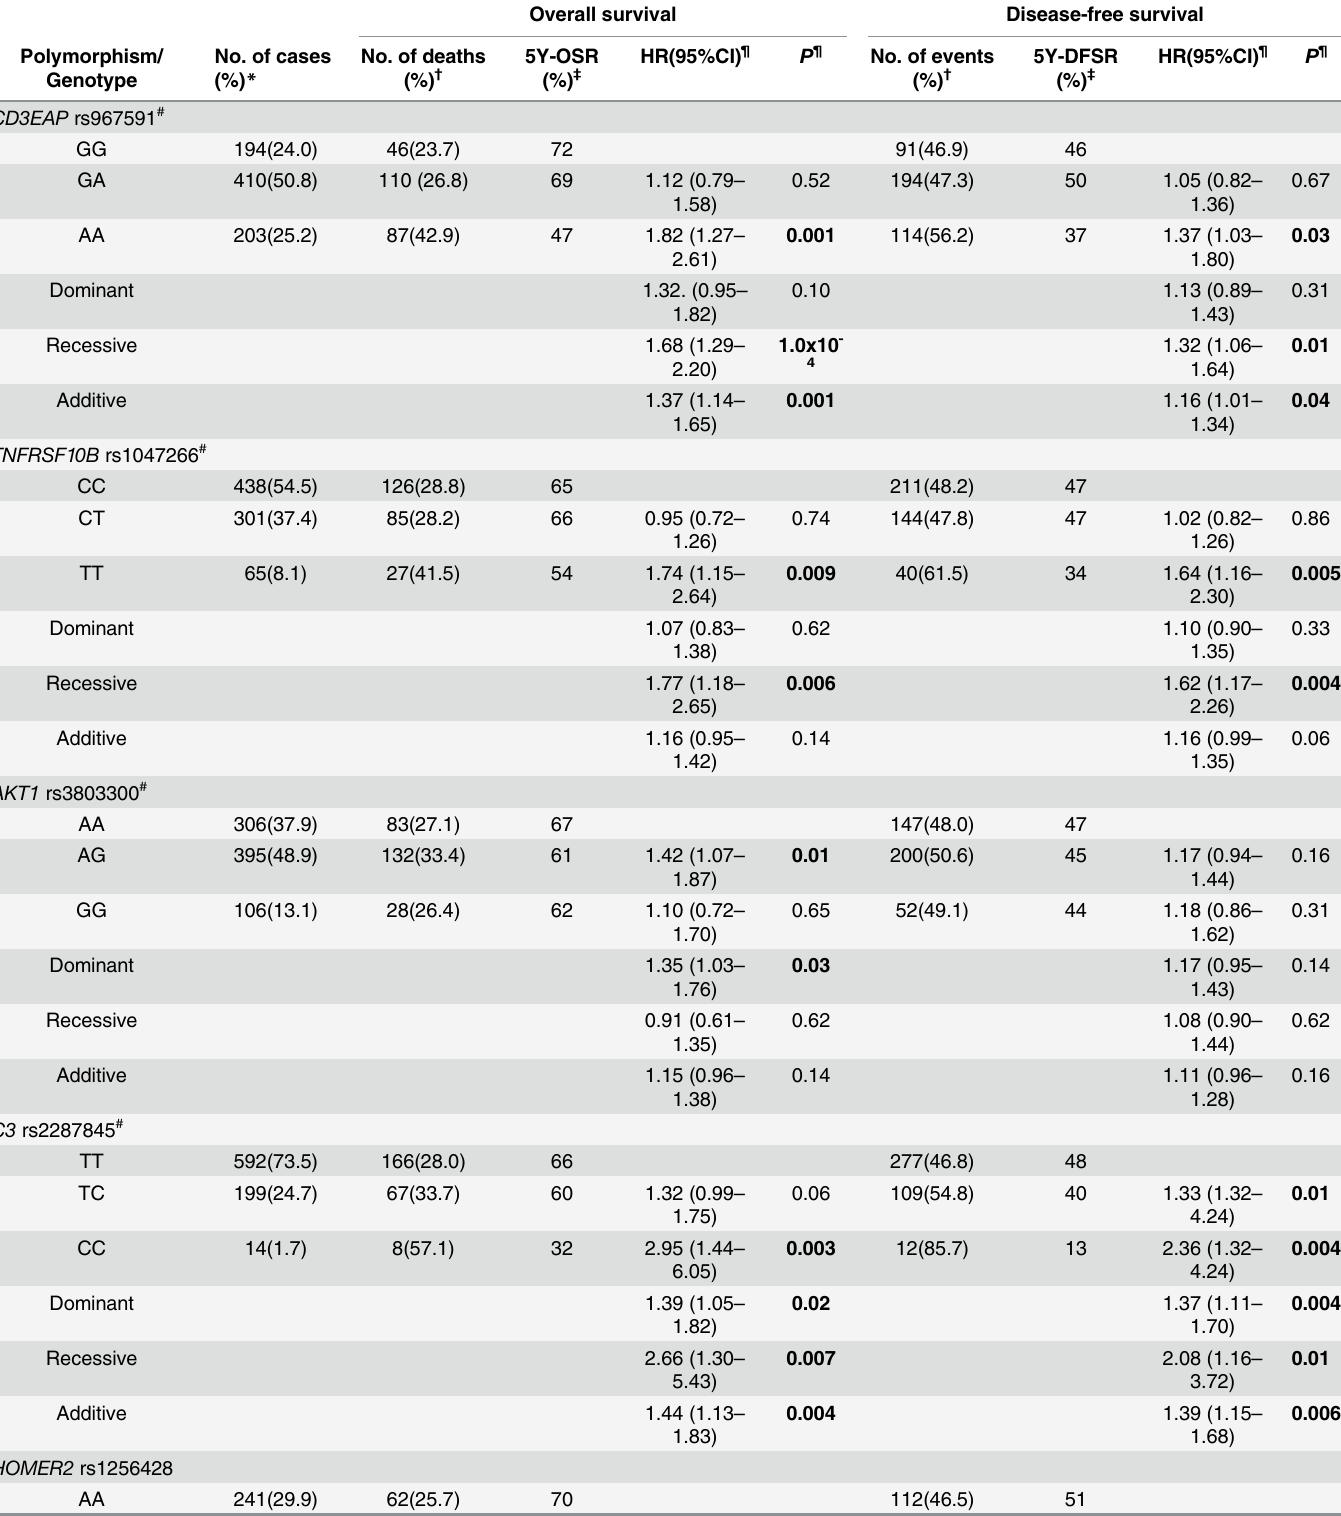
Overall survival Disease-free survival